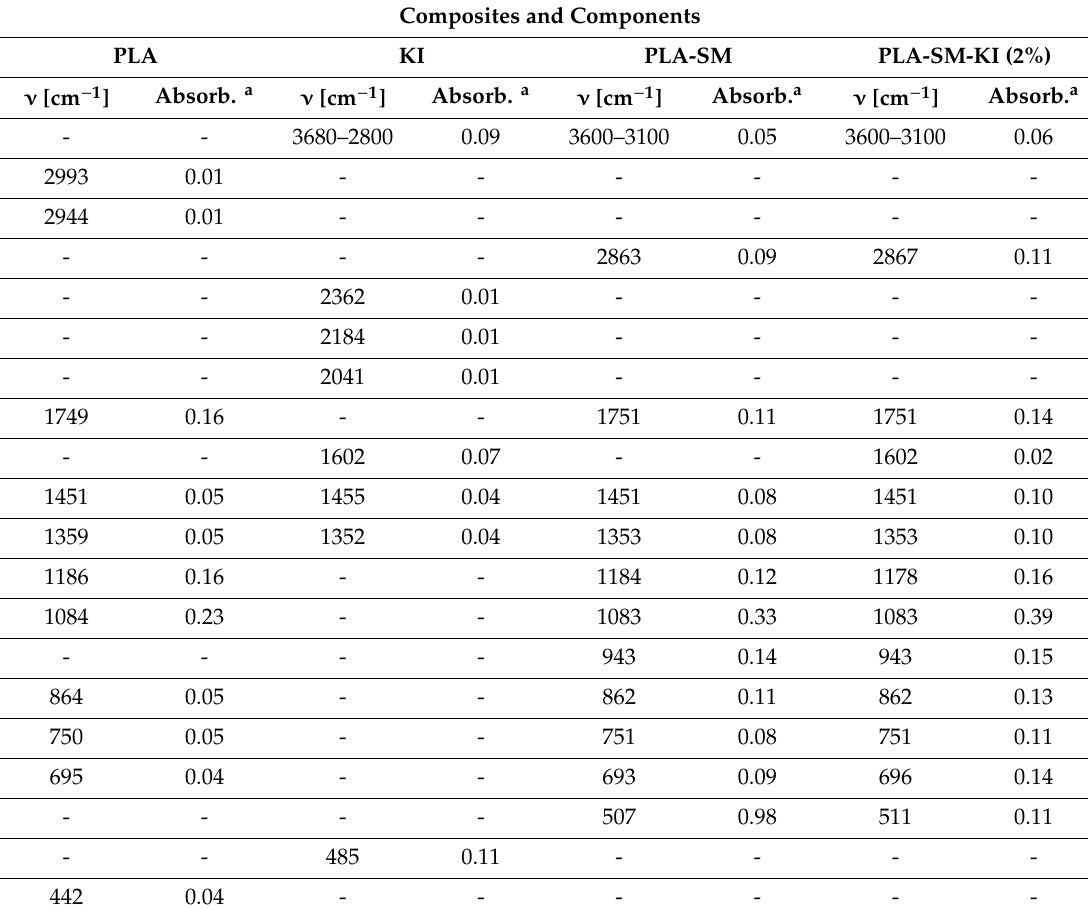
Figure 8. Attenuated Total Reflectance Fourier-Transform Infrared Spectroscopy (ATR-FTIR) spectra of PLA, PLA-SM, PLA-SM-KI (2%) and KI, range 400–4000 cm − 1 .